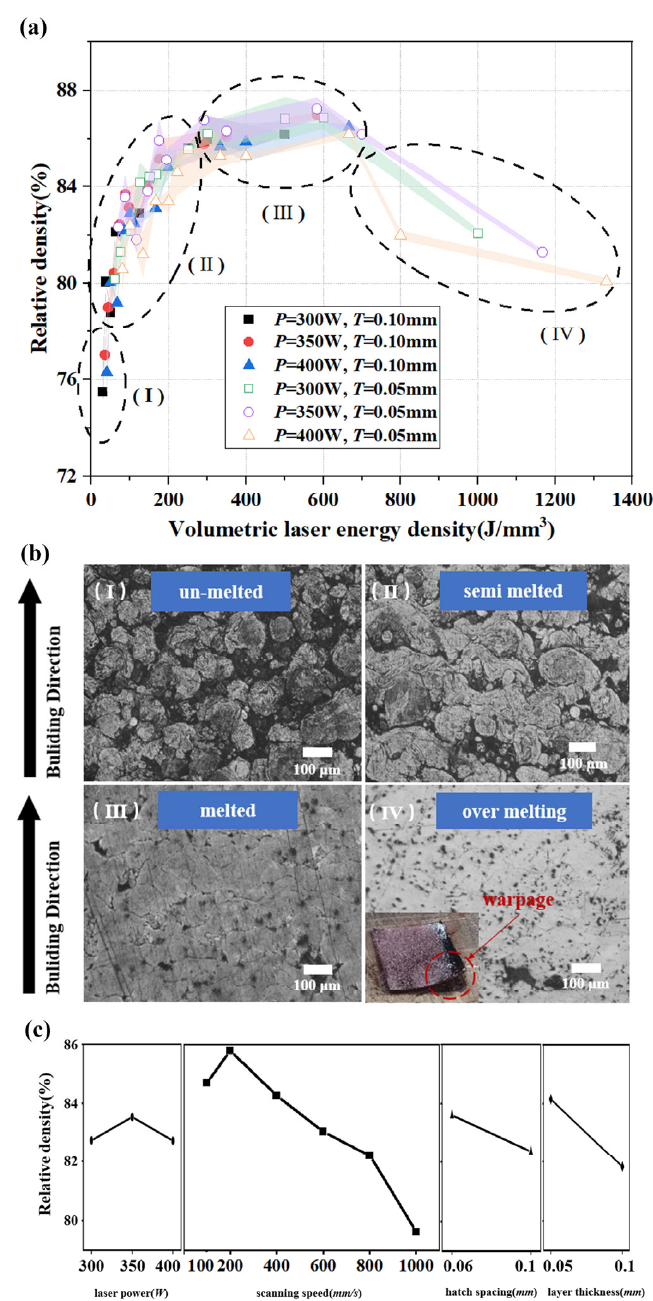
Figure 4. ( a ) Relative density of the fabricated copper samples with different process parameters in the function of the volumetric laser energy density. ( b ) Cross-sectional surfaces of metal samples observed under an optical microscope (I–III) and pictures of over-melting samples (IV). ( c ) Trends of factors and relative density.